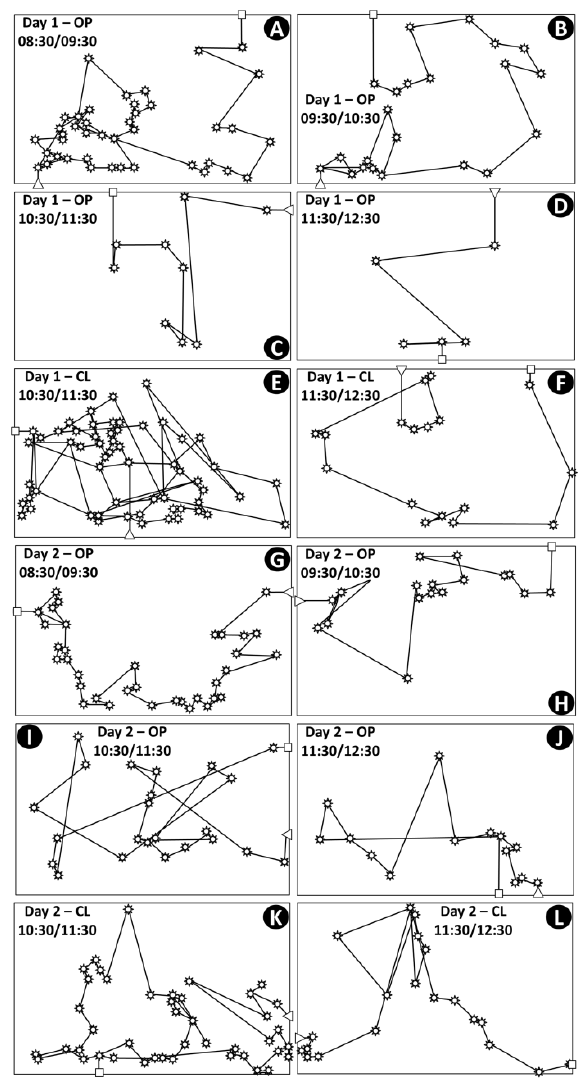
F IG . 3. Longest honey bee ( A. mellifera observed within the OP and CL plots while foraging on palmifolium , according to each day and each hour considered in the experiment. Day number and hour are given within each figure Circles represent flowers’ positions in the plot; open triangles represent path’s start; open squares represent path’s finish in the plot. Note the decline in path distances in the OP plot on day 1 and day 2 from early morning until anthesis (A vs. B vs. C vs. D; then G vs. H vs. I vs. J), and the decline on the closed time of opening until anthesis (E vs. F; then K vs. L). Also note the differences between the lengths of foraging paths at the same times of day but on the different plots (C vs. E and D vs. F for day 1 and I vs. K and J vs. L for day